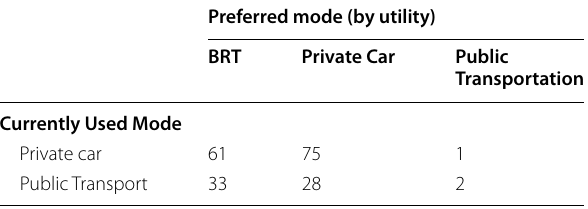
Table 4 Cross‑classification of actual and preferred transport mode computed by the utility function Preferred mode (by utility)